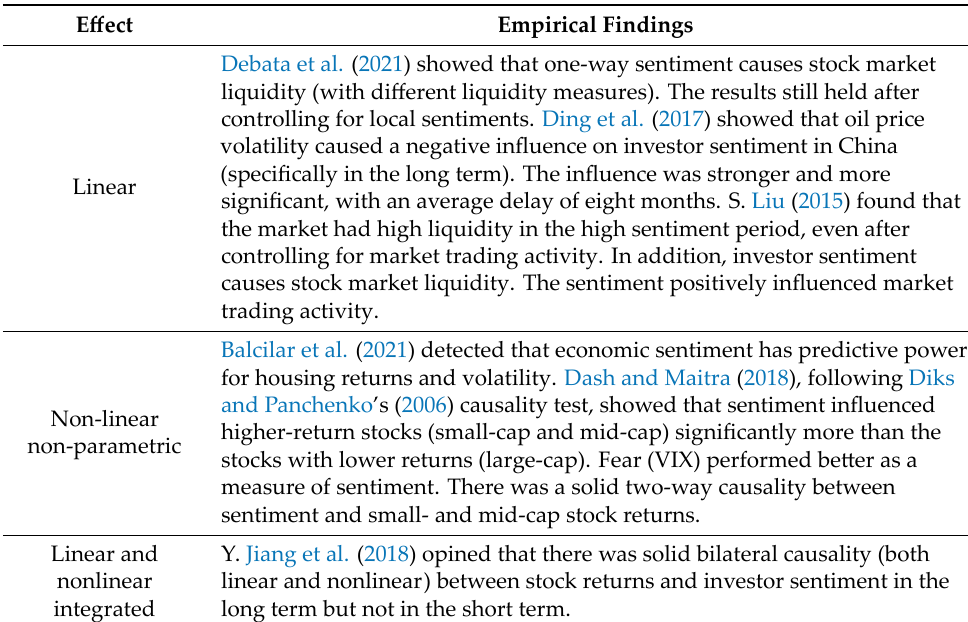
Table 8. Causality